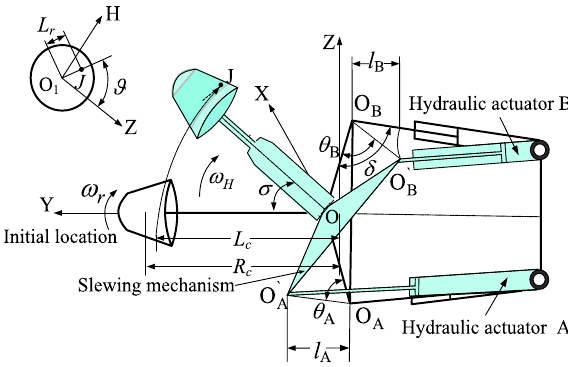
Figure 2. Spatial position of the cutting head and the hydraulic